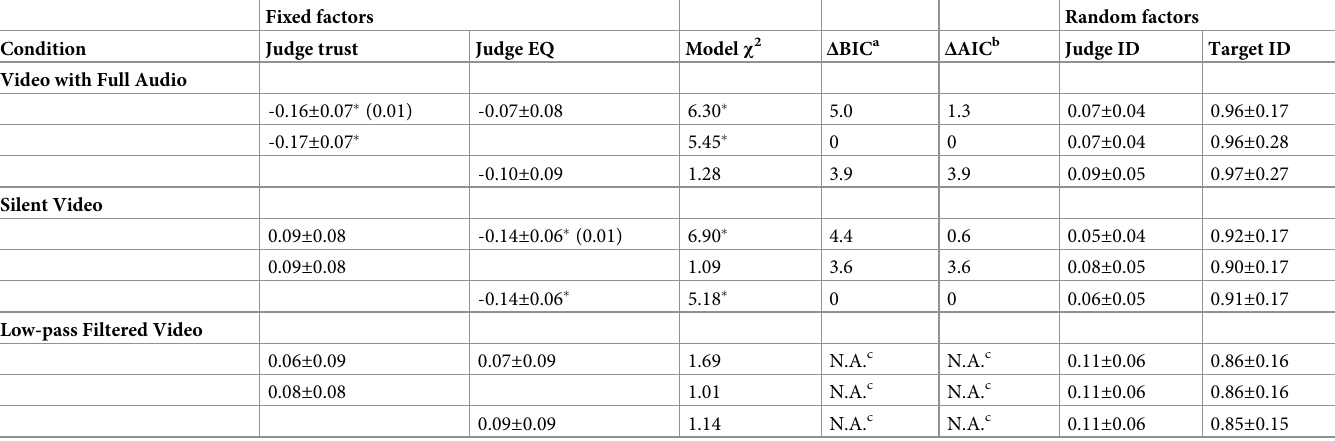
cooperation from co-participants. Possibly, the same non-verbal or extra-semantic behavioral features that promote recognition of secondary psychopathy by judges also elicit greater coop- eration from interlocutors. Judgments of total psychopathy (i.e. the entire LSRP/LORP scale) were not significantly accurate in any experimental condition. Table 11. Multilevel mixed regression models predicting LORP-LSRP standard difference score for secondary psychopathy. Fixed